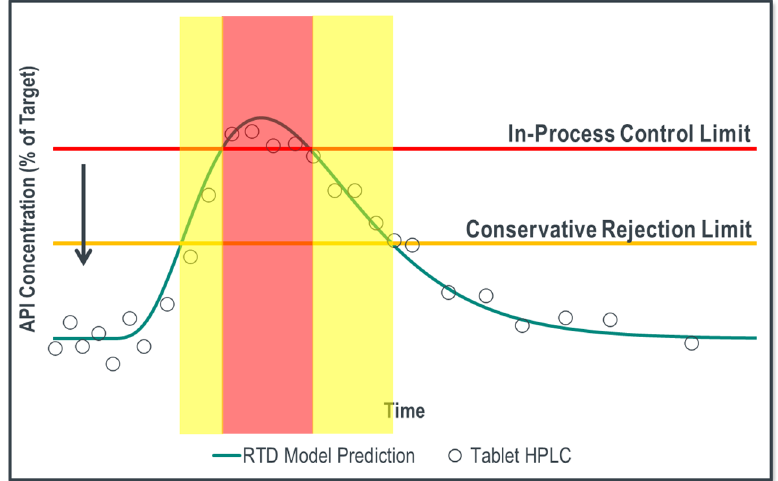
Figure 17. Graphical representation of implementing conservative rejection limits, where the red line is the product’s traditional in-process control limit and the yellow line is the calculated rejection limit.